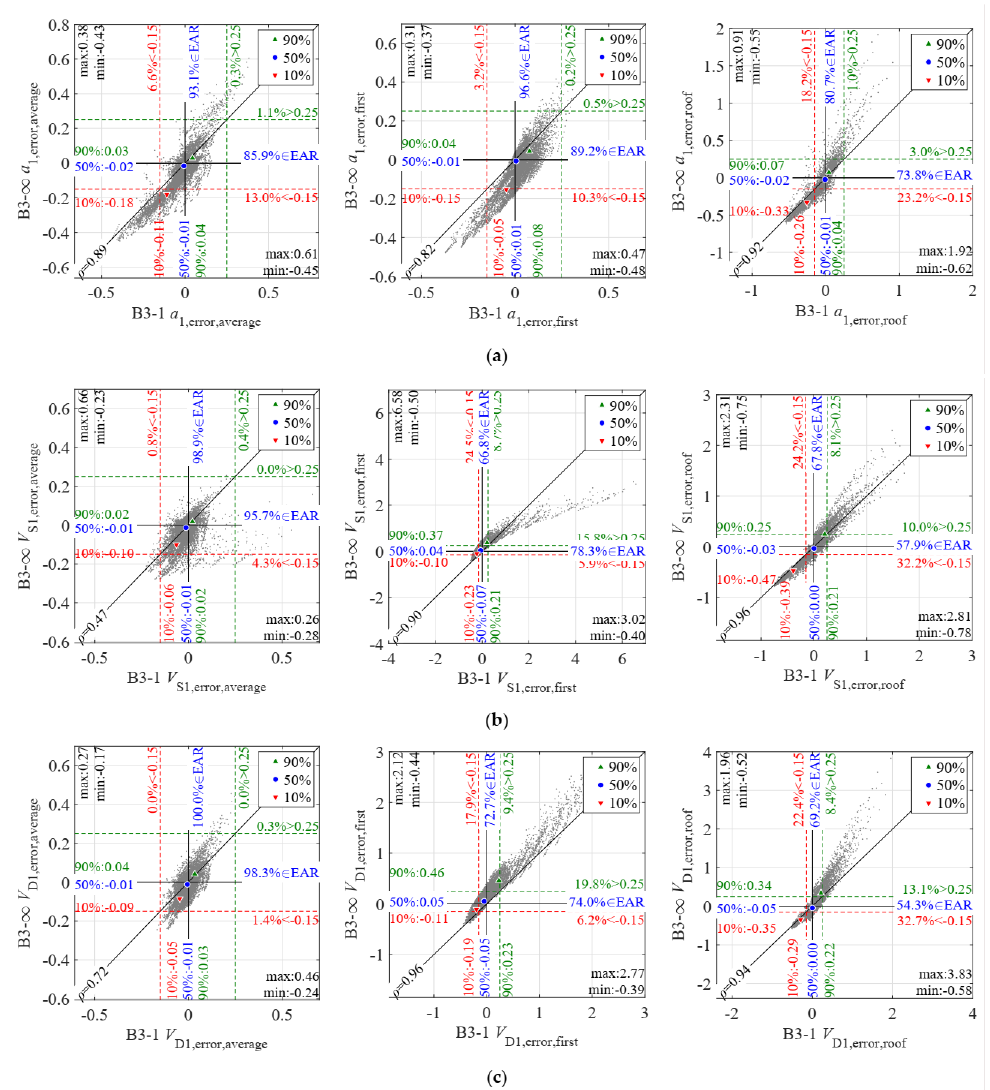
Figure 5. Scatter plots of case B3-1 versus case B3- ∞ at average of stories (left column), first story (central column) and roof (right column) for static variables: ( a ) absolute acceleration a ; ( b ) story shear V S ; ( c ) damping shear V D